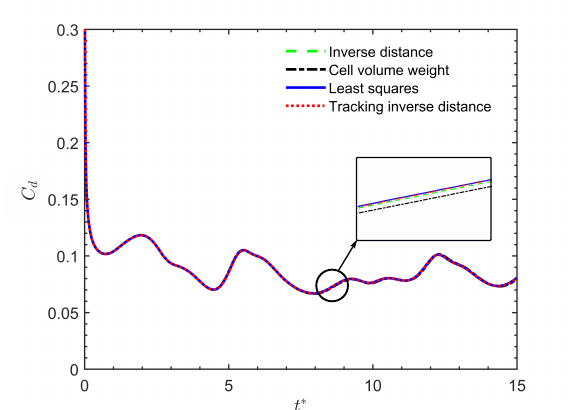
Figure 6. Variation of C d with time for 2D stationary panel ( α = 30 deg), estimated using different overset interpolation techniques.